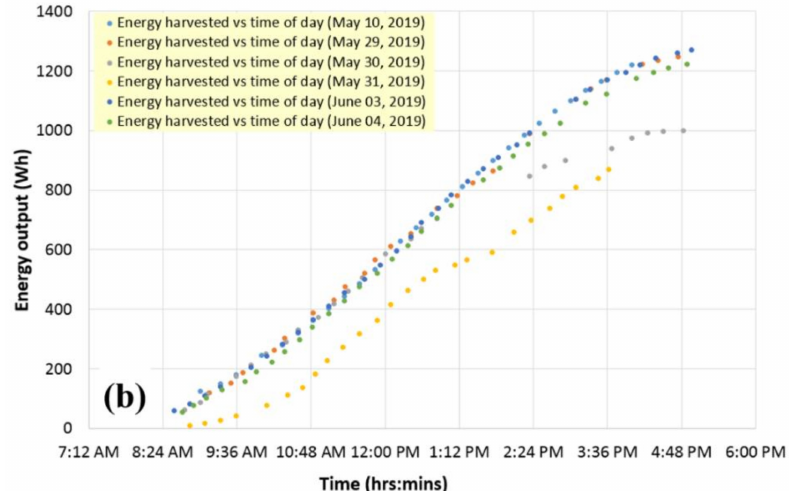
Figure 4. Energy harvesting performance of 18-window solar atrium versus time of day. (a) Electric power output readings recorded over several days in May-June 2019; (b) the amounts of stored electric energy vs time of day; the data points used are from the same dataset of system-state records as in part ( a